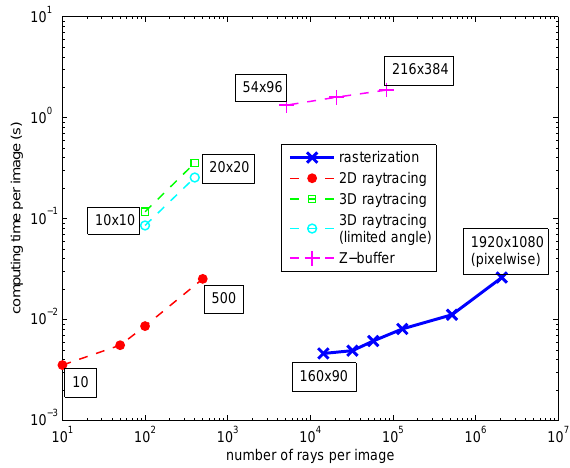
Figure 5: Timings for visibility computation. Results are com- pared between our rasterization approach (thick blue line) with subsampling factors ranging from 1 to 24, and the three ap- proaches of B´enitez (dotted